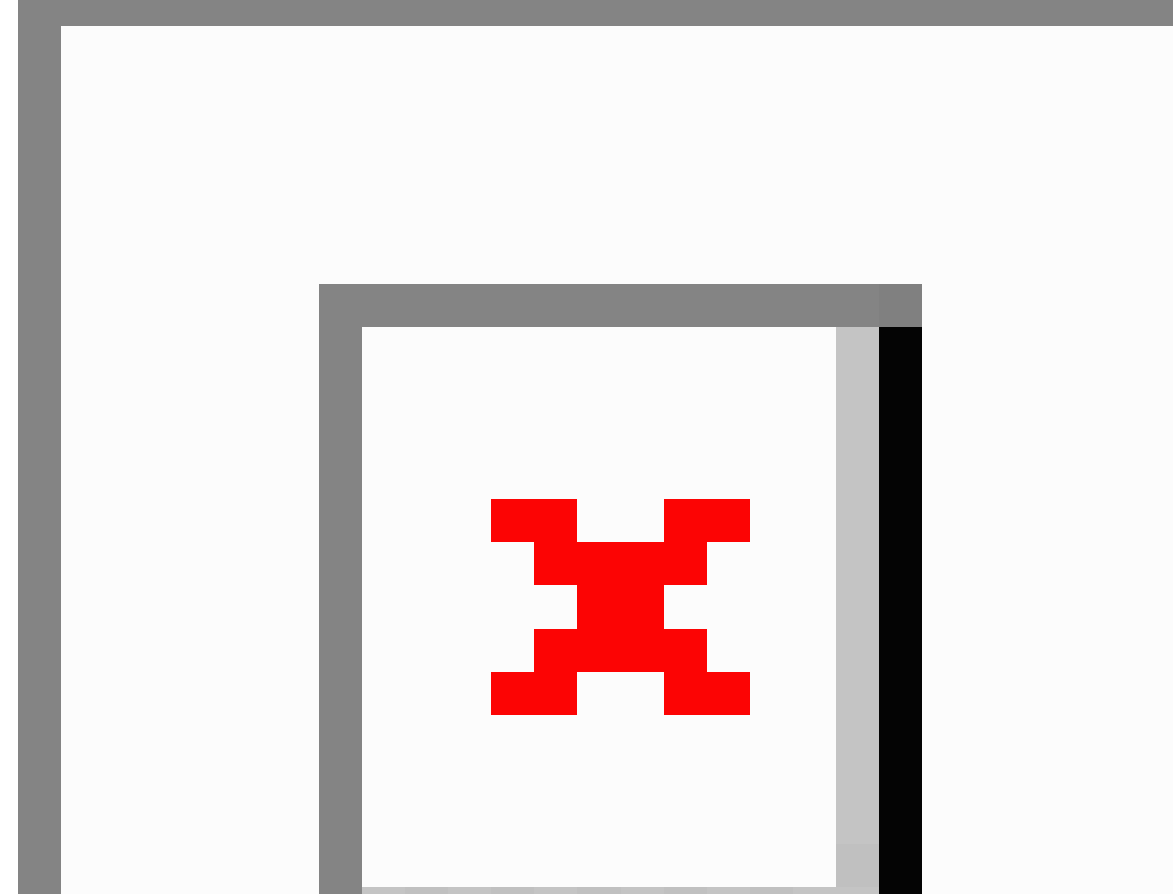
Figure 4. Average (SE) percentage change in step count in each period relative to the first time period (P1) for participants with complete data (ie, no missing